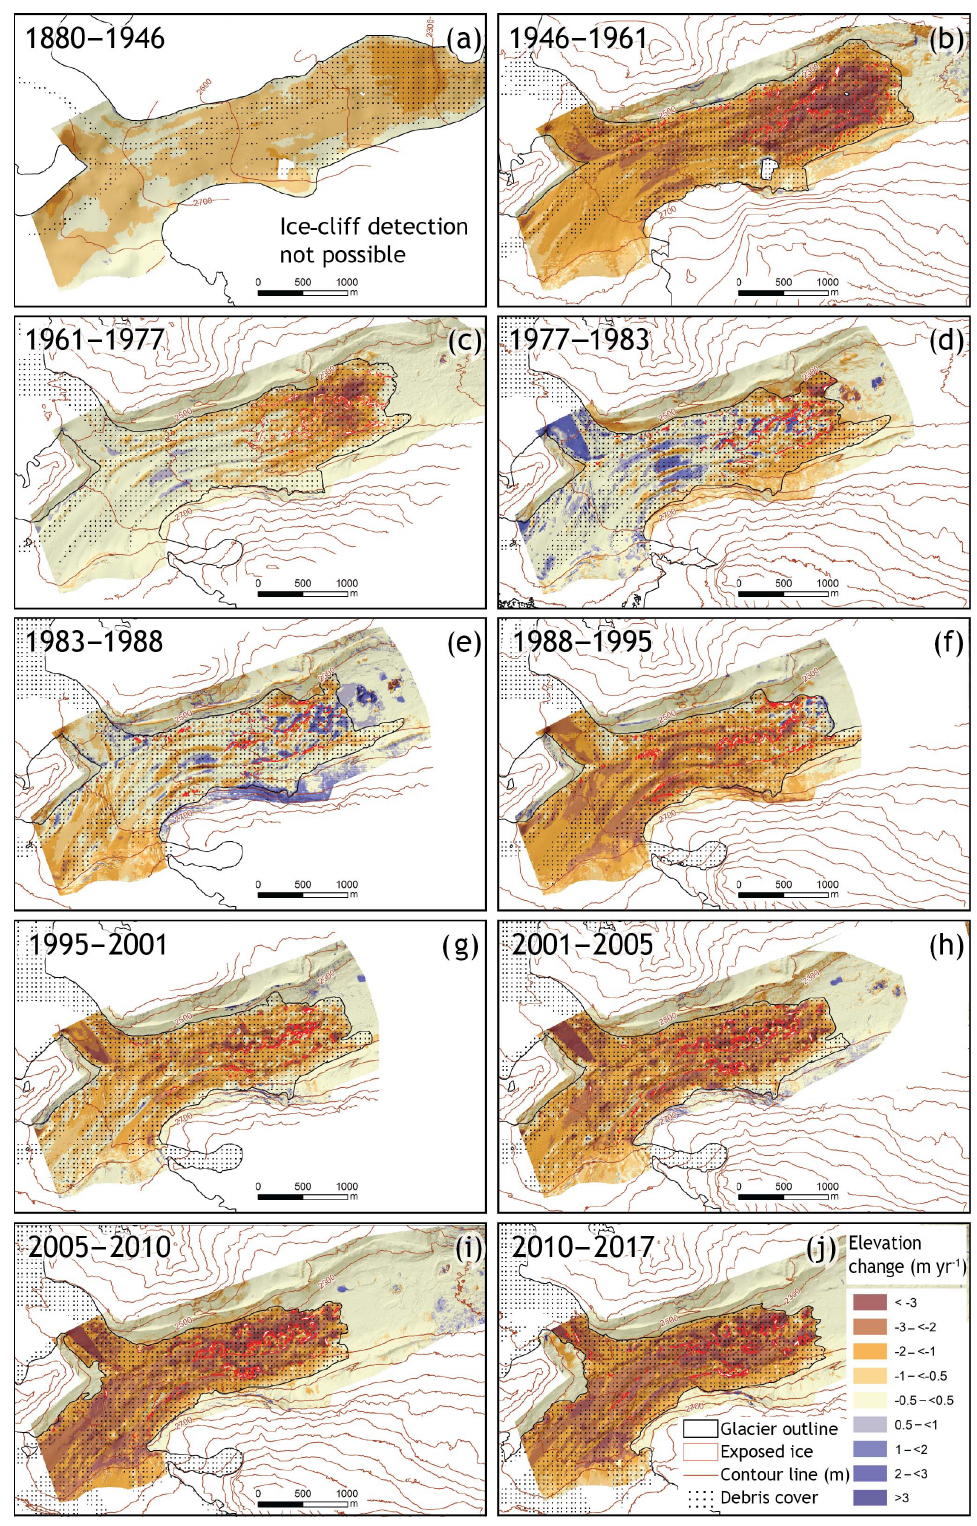
Figure 10. Evolution of elevation change over the glacier tongue since 1879. Ice-cliff areas are shown in red. Note how the “wave” of mass flux moves down-glacier from (c) – (f) . High values in the glacier forefield (e.g. 1983–1988) are linked to artefacts from water surfaces and the activities of a gravel mining company. See Figs. S7 to S16 in the Supplement for enlarged panels.